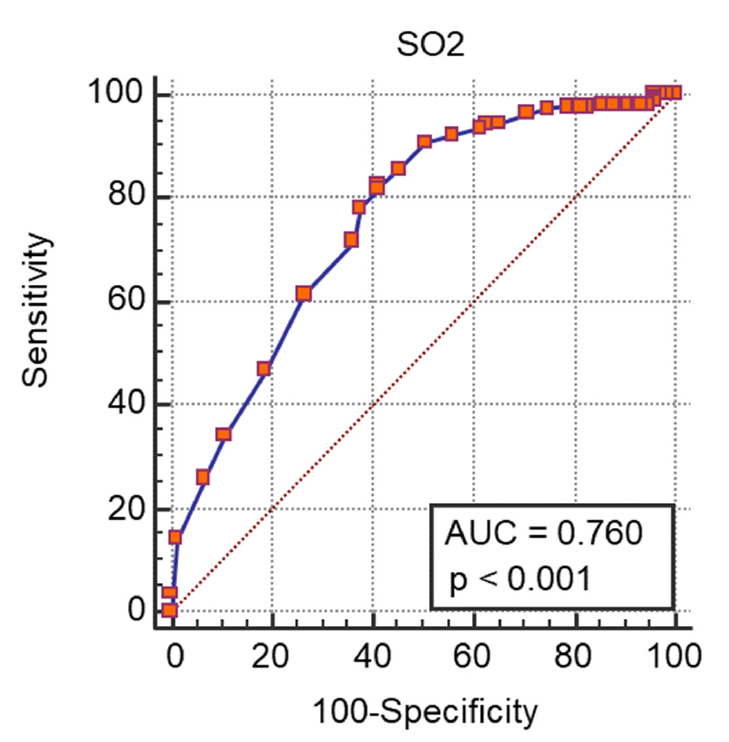
Figure 3. ROC curve e AUC values for SO2 and ICU admission.